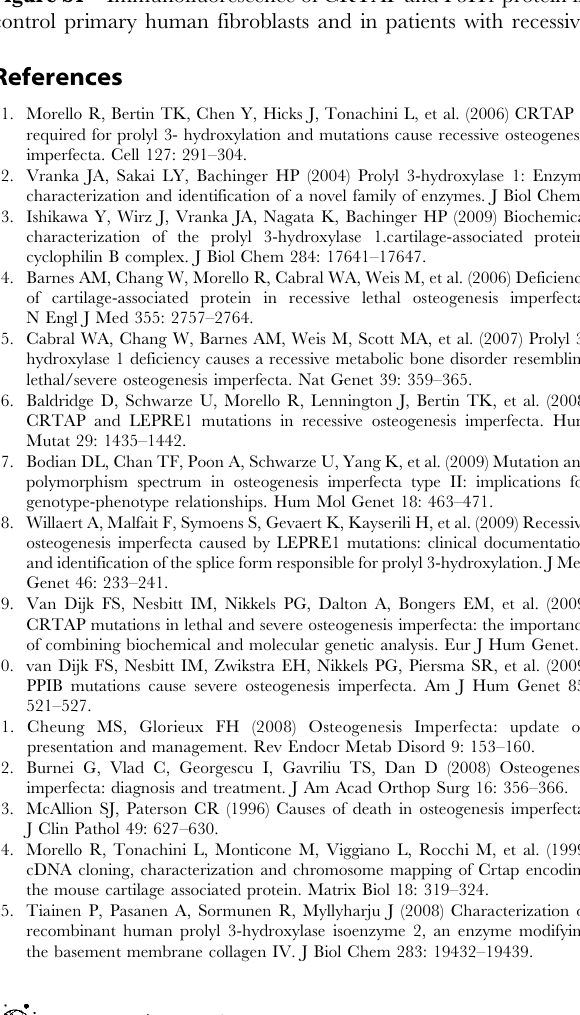
Figure S1 Immunofluorescence of CRTAP and P3H1 protein in control primary human fibroblasts and in patients with